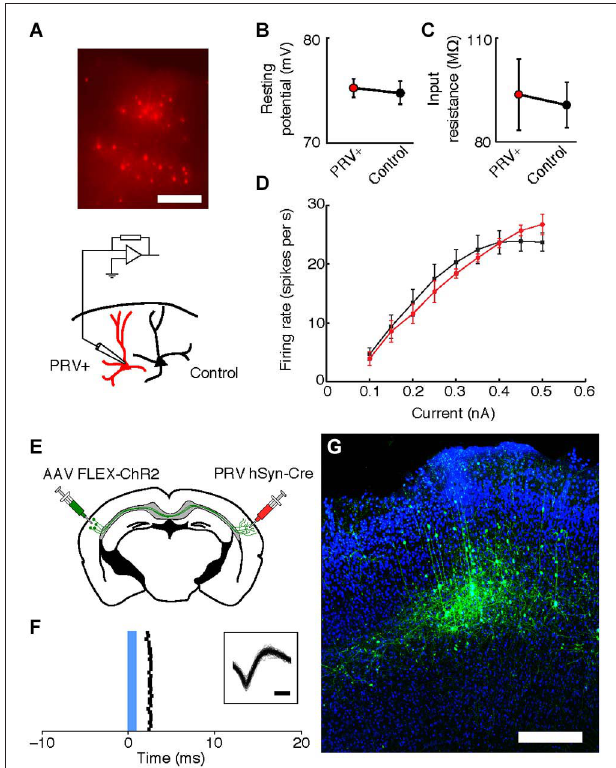
FIGURE 5 | Intrinsic properties of PRV IE180-null hSyn-Cre infected neurons are indistinguishable from control cells 40–70 days after infection. (A) tdTomato fluorescence in neurons retrogradely labeled with PRV IE180-null hSyn-CRE in an acute slice of Auditory cortex before recording. Scale bar ∼ 200 um. (B) Resting potential is unaffected in PRV infected neurons ( p = 0.7266). (C) Input resistance is unaffected in PRV infected neurons ( p = 0.8750). (D) F/I (firing rate/current) curves are unchanged by PRV infection ( p = 0.7153). (E) Strategy for ChR2-tagging of callosal projection neuron in Auditory cortex using PRV-hSyn-Cre. (F) Raster of light-evoked responses of a presumed callosal projection neuron. Blue bar- light stimulus. Inset shows extracellular spike waveforms of this neuron, bar—200 us. (G) ChR2-YFP expression in PRV-tagged callosal projection neurons in the auditory cortex. AAV- EF1a -DIO-hChR2 (H134R)-EYFP was injected into the left auditory cortex and IE180-null PRV-hSyn-Cre was injected into the right auditory cortex, shown here is the left auditory cortex with callosal projection neurons labeled as a result of dual infection. Scale bar—300